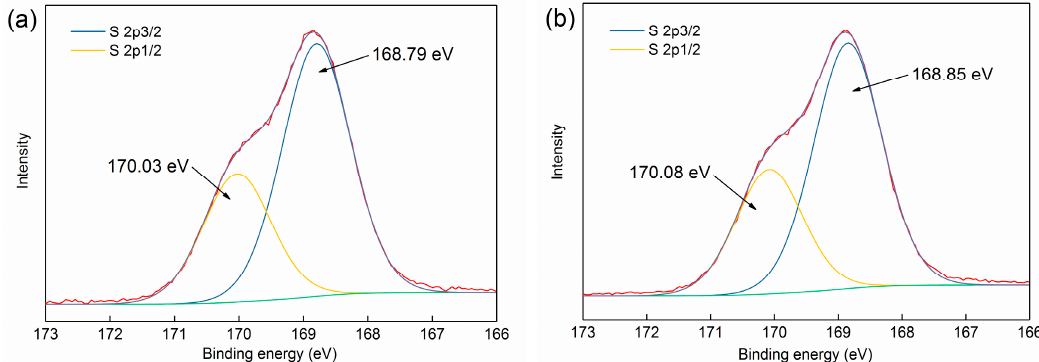
Figure 6. S 2p spectra of ( a ) untreated celestite and ( b ) celestite treated with ferric ions (The red lines are original curves and the green lines are background curves).